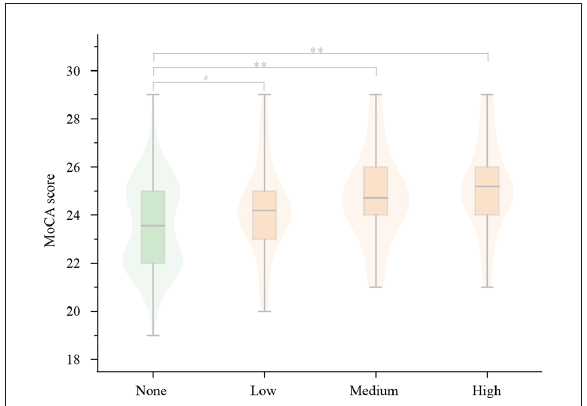
FIGURE4 The results of subgroup analysis for MoCA scores. Compared with the non-consuming group, the MoCA score gradually increased in the low, medium, and high group, of which there was a significant difference only in the medium and high group, but not in the low group. MoCA, Montreal Cognitive Assessment scale. ∗∗ P < 0.001; # P ≥